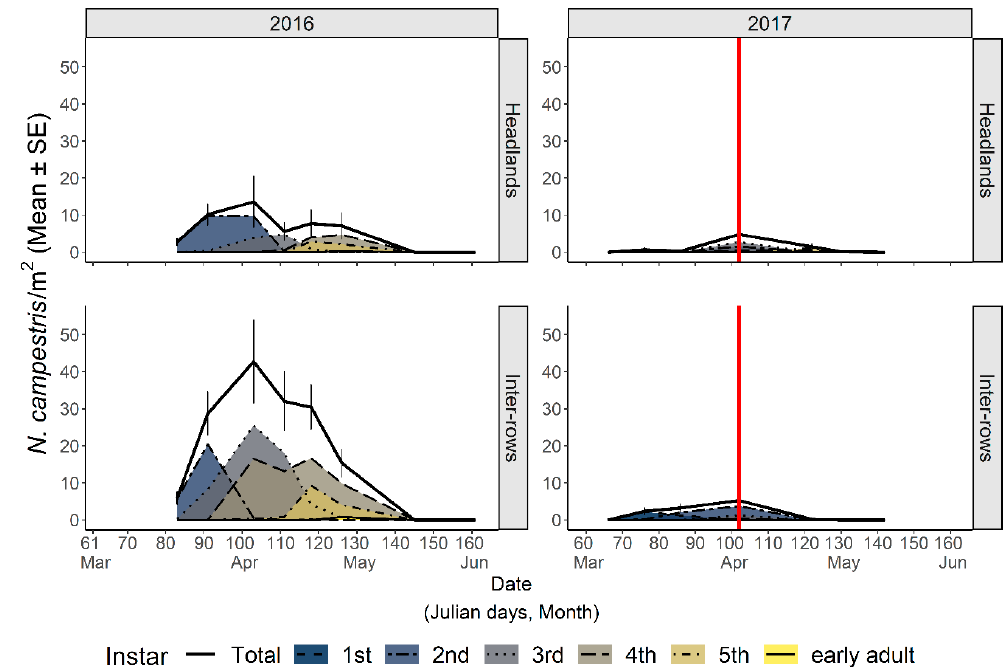
Figure 3. Life-stage structure of the preimaginal populations of Neophilaenus campestris in vineyard inter-rows and headlands. The curves area of each nymphal instar, the total nymphs, and the newly emerged adults are represented as mean densities by sampling date. Red vertical lines represent the date of mowing treatment. Data refer to the 2016–2017 survey in Asti.